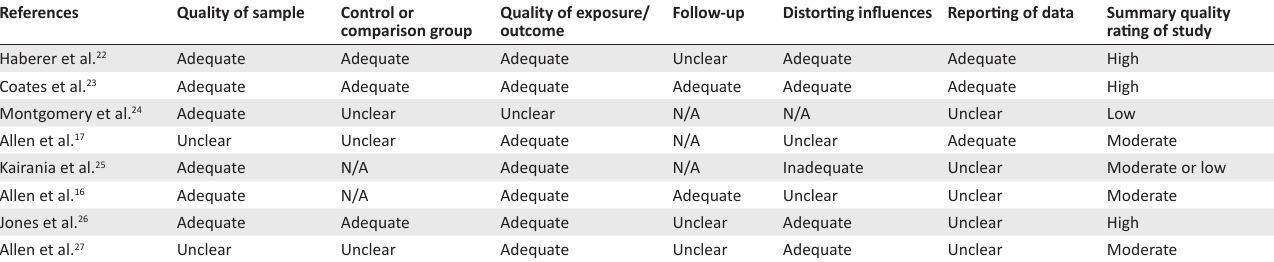
TABLE 1: Quality assessment of included studies using the Systematic Appraisal of Quality in Observational Research